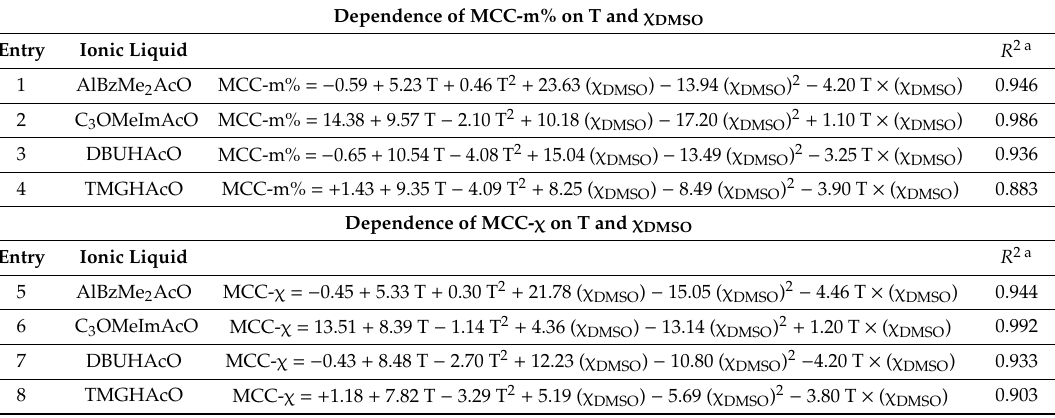
Table 2. Regression equations for the dependence of the concentration of dissolved cellulose on the temperature (T) and the mole fraction of DMSO ( χ DMSO